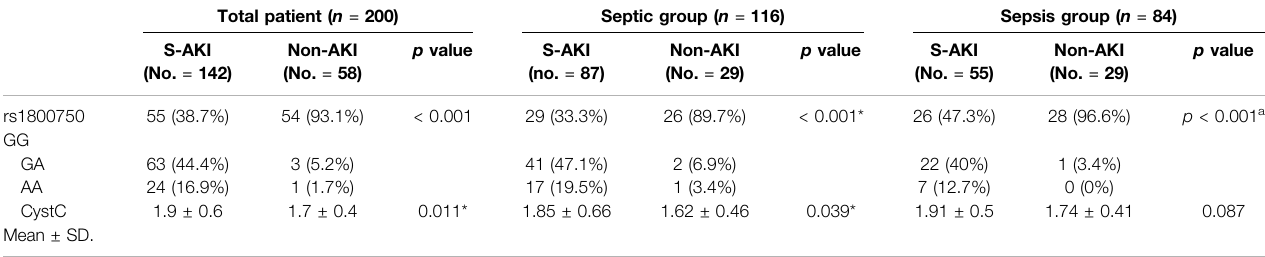
TABLE 3 | Distribution of TNF α gene (rs1800750) and Cyst C according to the S-AKI and non-AKI groups.